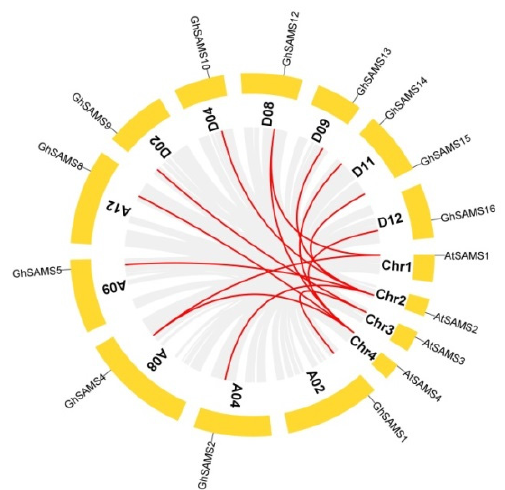
Table S2. There were 14 pairs of homologous SAMS genes between upland cotton and Arabidopsis, of which 6 pairs were shown between the A genome of upland cotton and the Arabidopsis genome, and 8 pairs were shown between the D genome and the Arabidopsis genome (Figure 4). The results of the collinearity analysis revealed that the main expansion mechanism of the SAMS gene family is WGD/segmented and scattered duplication events, rather than proximal and tandem duplication events.